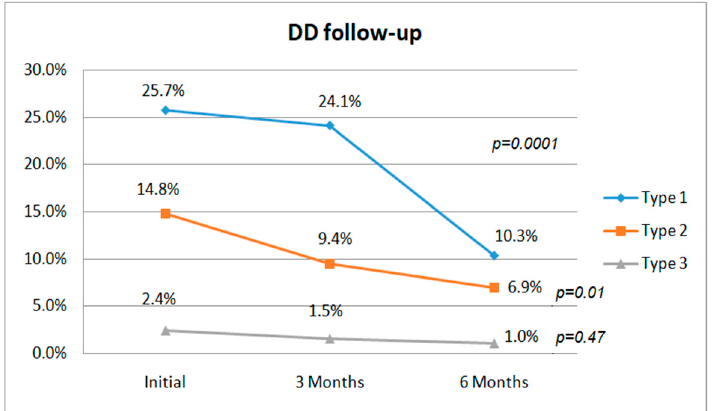
Figure 2. DD distribution at the initial evaluation and at 3 and 6 months after COVID-19 infection, respectively.